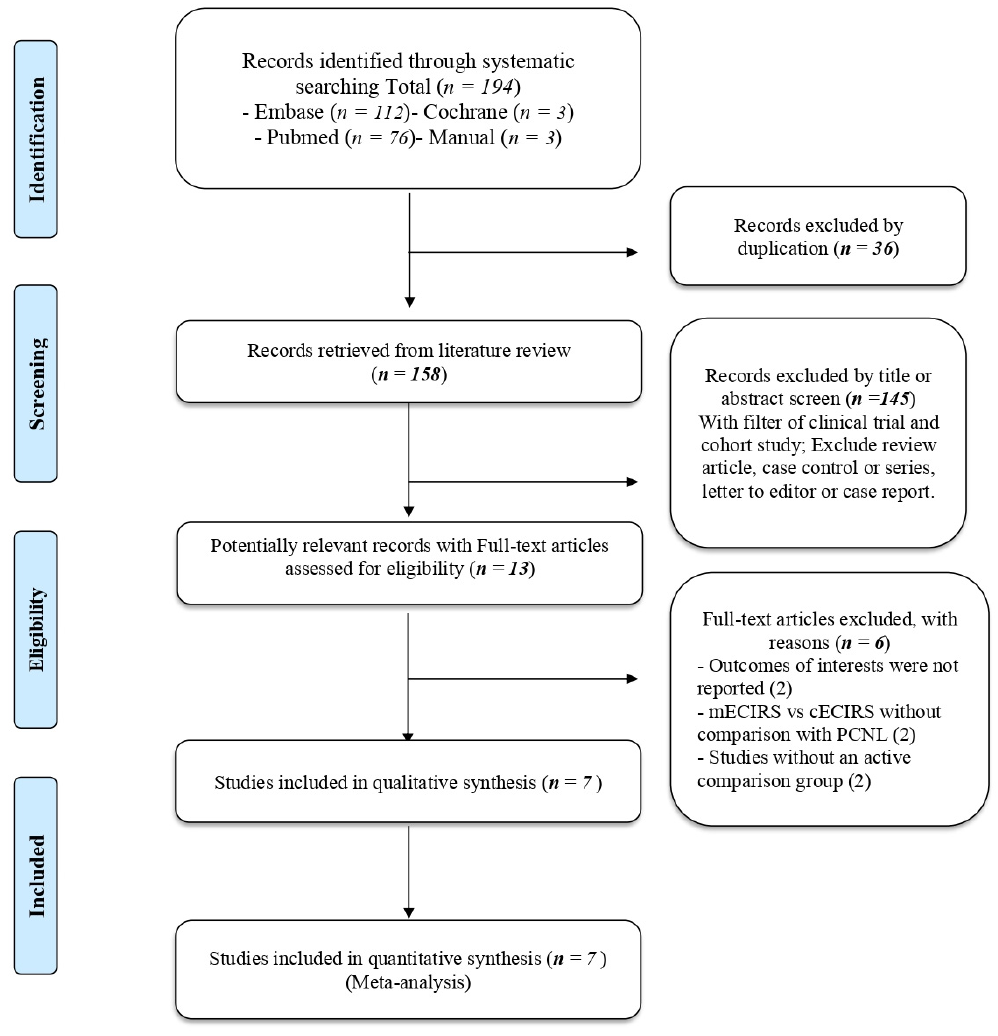
Figure 1. PRISMA flow diagram. mECIRS: mini-endoscopic combined intrarenal surgery, cECIRS: conventional endoscopic combined intrarenal surgery, PCNL: percutaneous nephrolithotomy .